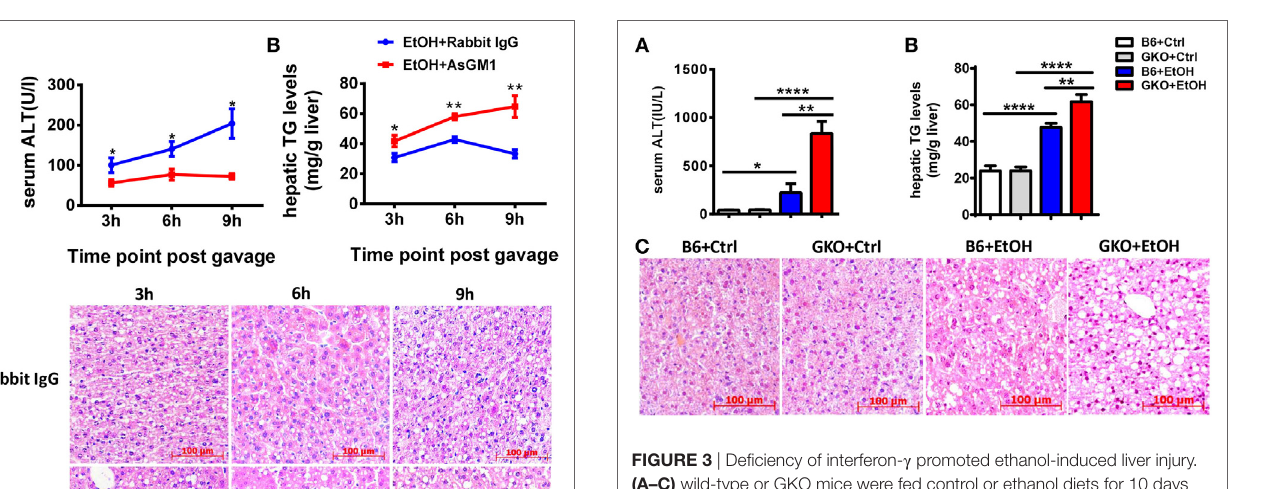
FigUre 3 | Deficiency of interferon- γ promoted ethanol-induced liver injury. (a–c) wild-type or GKO mice were fed control or ethanol diets for 10 days and received a gavage. The mice were sacrificed 9 h after gavage, and liver injury and steatosis were evaluated based on (a) serum alanine aminotransferase and (B) liver triglyceride levels and (c) liver tissue hematoxylin and eosin staining (original magnification, 200 × ). The data are representative of more than three independent experiments and are shown as the mean ± SEM ( n = 4–11). * P < 0.05; ** P < 0.01; **** P < 0.0001.